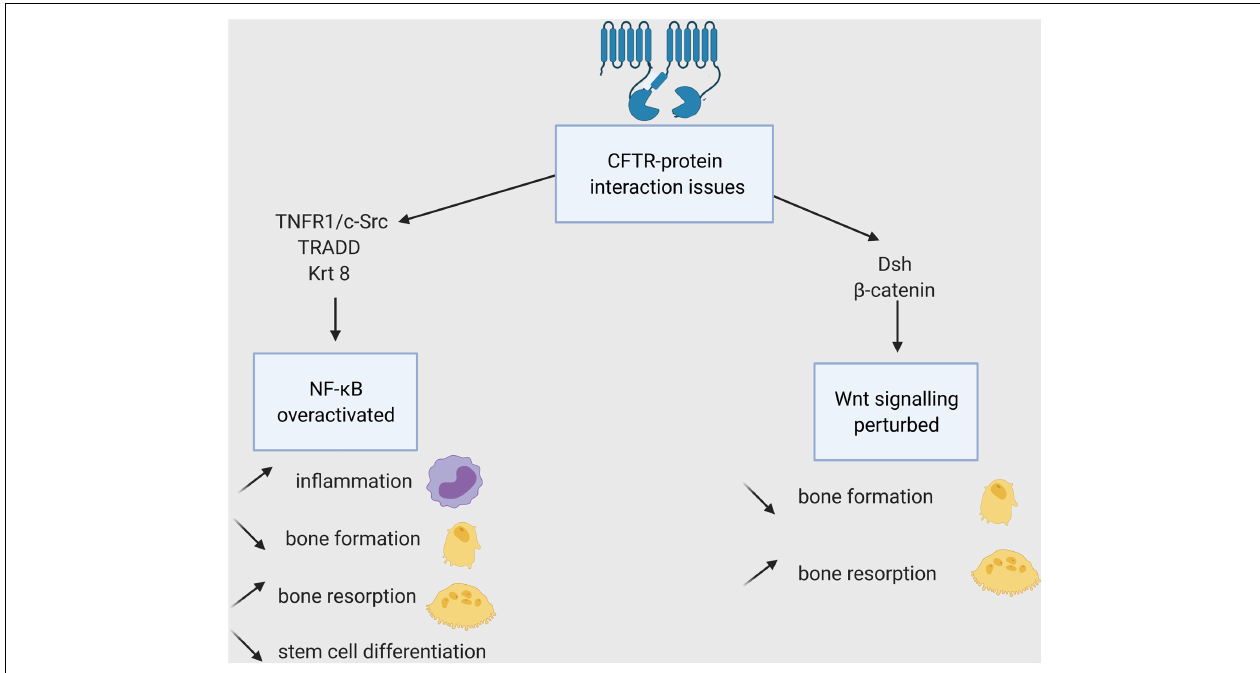
FIGURE 4 | Impacts of the CFTR-proteins interactions loss on bone cells. WT-CFTR, because of its PDZBD interacts with c-Src, TNFR1 and TRADD (shown in epithelial cells), Krt8 (in osteoblasts), and Dsh (in osteoblasts, osteoclasts, and osteocytes). The lack of these interactions leads to NF-KB overexpression and Wnt signaling disruption and to several consequences for bone cells and their